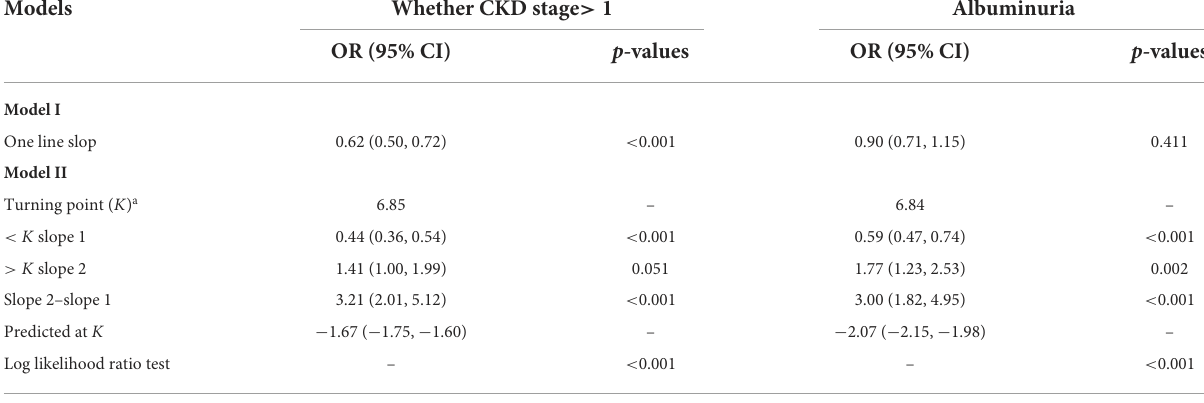
TABLE 3 Threshold effect analysis for the association between serum Klotho concentrations and two categorical dependent variables: Whether CKD stage > 1 and albuminuria a .